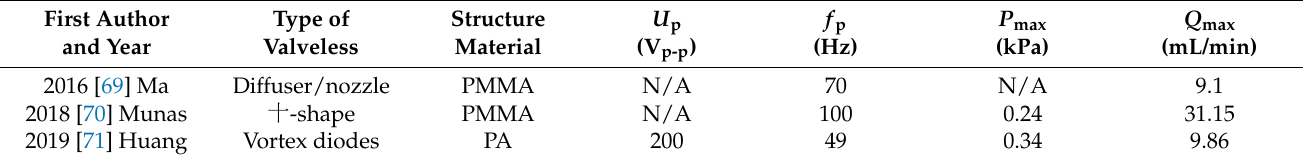
Table 6. Summary of properties for other valveless piezoelectric pumps.